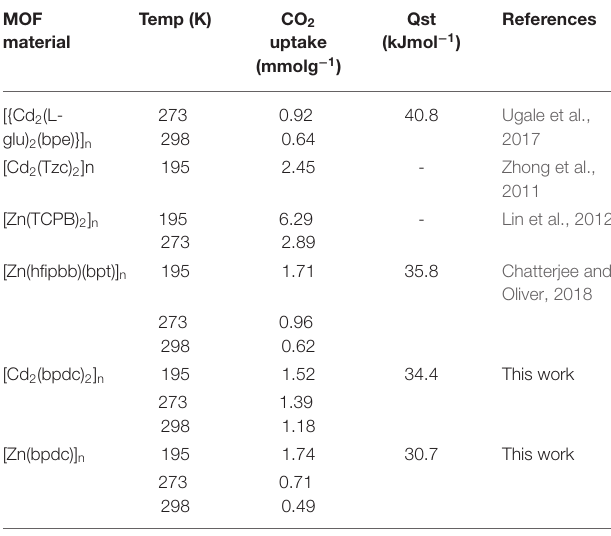
TABLE 2 | A comparison of CO 2 adsorption capacity for various Cd and Zn based MOFs at 1